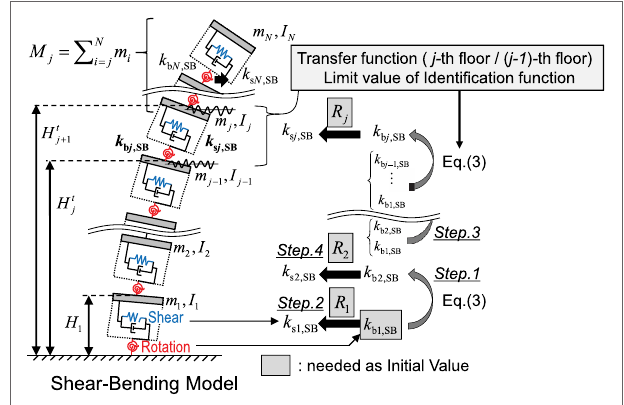
FIGURE 1 | System identification using shear-bending model based on the identification function